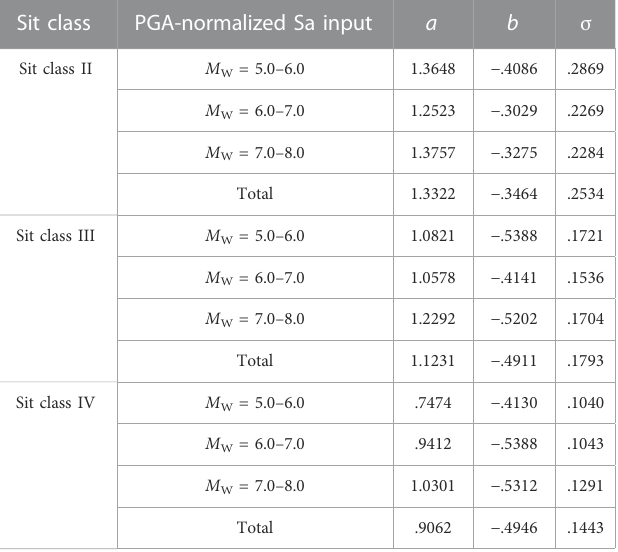
TABLE 2 Fitting coef fi cients for PGA ampli fi cation factors given by numerical simulations. Sit